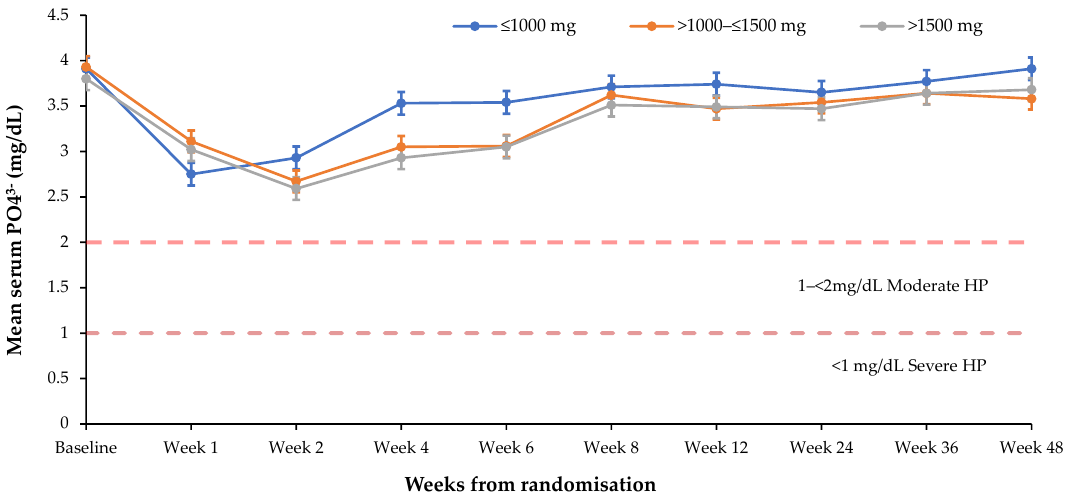
Figure 3. Mean serum PO 43 − by ferric carboxymaltose dose (single vs. multiple). Single dose n = 2808, multiple dose n = 4071. Multiple dose is defined as doses given in a minimum of two di ff erent administrations. Bars denote standard error of the mean. The drop in serum PO 4 3 − was greater and longer lasting after multiple doses compared with a single dose. FCM, ferric carboxymaltose; HP, hypophosphataemia; PO 43 − , phosphate.